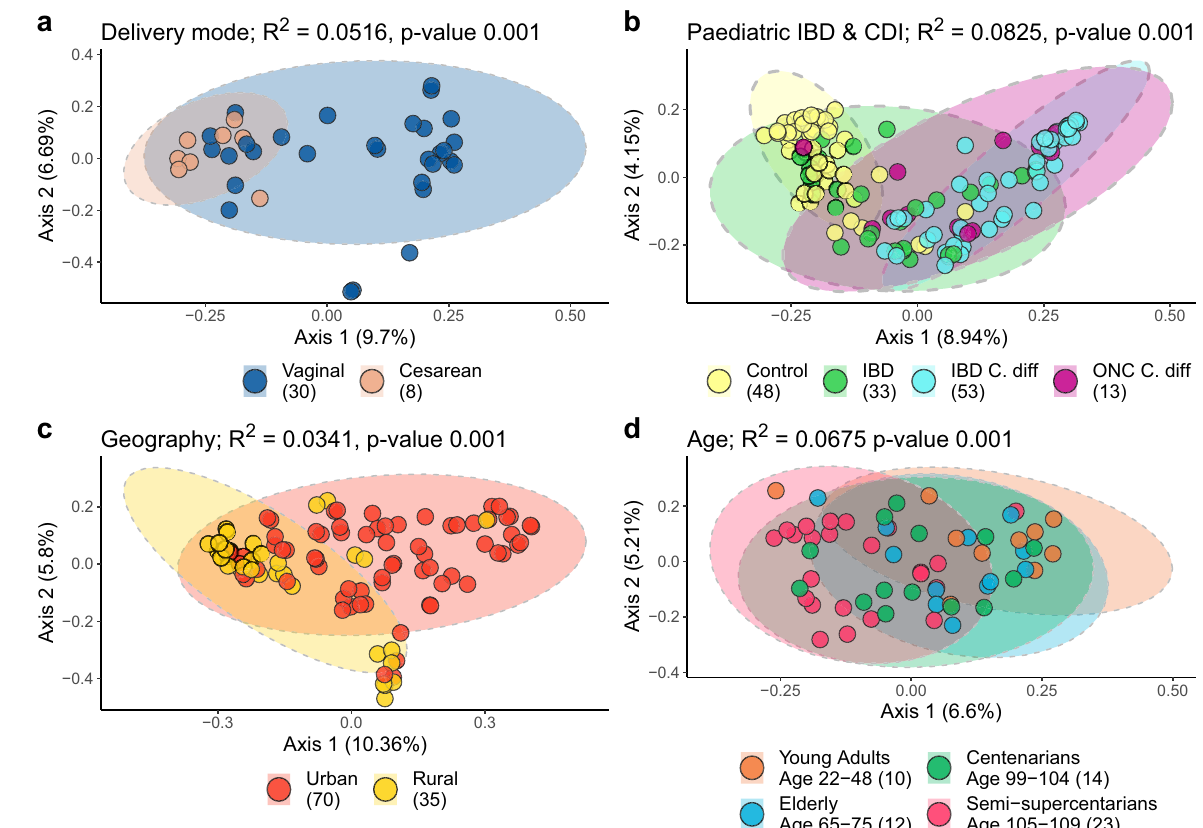
Figure 4. Inter-sample plasmidome differences are widespread across human metagenomic studies. Re-analysis of publicly available metagenomic data originally investigating microbiome differences associated with ( a ) birth mode, ( b ) paediatric IBD and CDI, ( c ) urban versus rural habitation, and ( d ) old age. Beta-diversity analysis was performed using PCoA ordination of Canberra distances. Image panel titles indicate variance (R 2 ) and p-values for permutational multivariate analysis of variance (PERMANOVA) tests, with the number of samples analysed per cohort indicated within the brackets of each panel